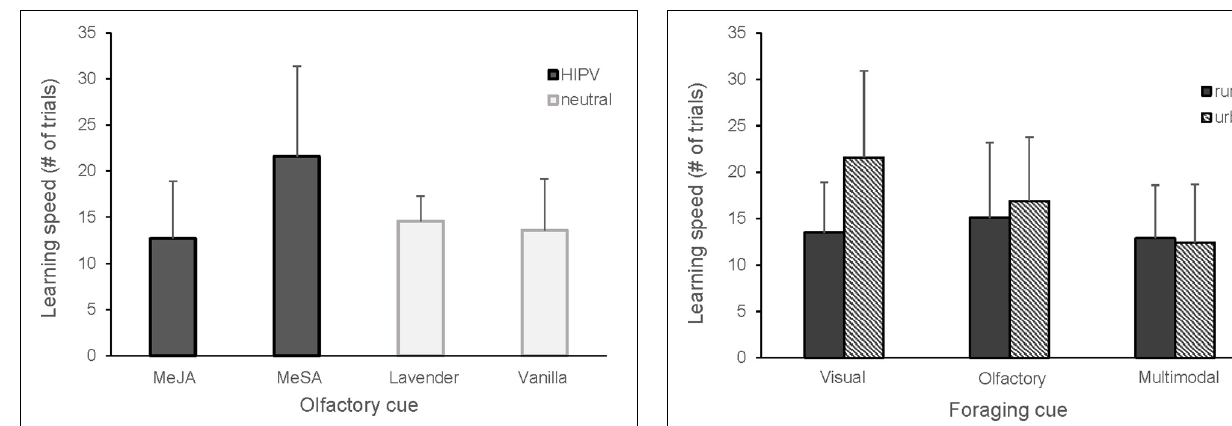
FIGURE 1 | Learning speed in great tits presented with HIPV (MeSA, MeJA) and neutral (lavender, vanilla) olfactory cues. Mean number of trials and standard deviation are shown. Twelve great tits each (4 females and 8 males) learned two cues. The learning speed was significantly higher for MeSA compared to MeJA (GLMM, p = 0.007) and vanilla (GLMM, p = 0.02), with a similar tendency for lavender ( p = 0.079).